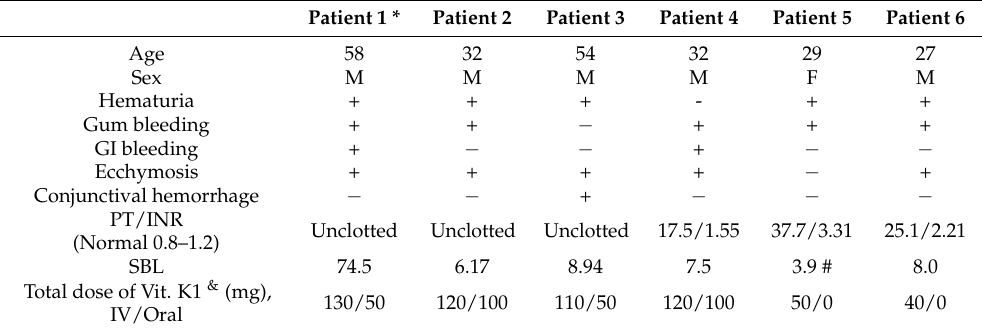
Figure 1. The appearance of the bait. The rice grains were stained unevenly by pink bromadiolone powder before being washed (the patient provided the rice grains). Table 1. Clinical and demographic data of the six patients with bromadiolone intoxication.